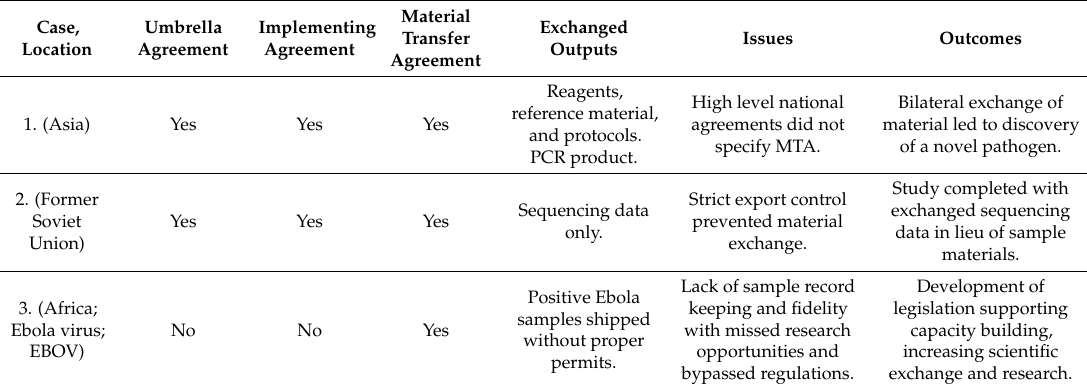
Table 1. Summary of Case